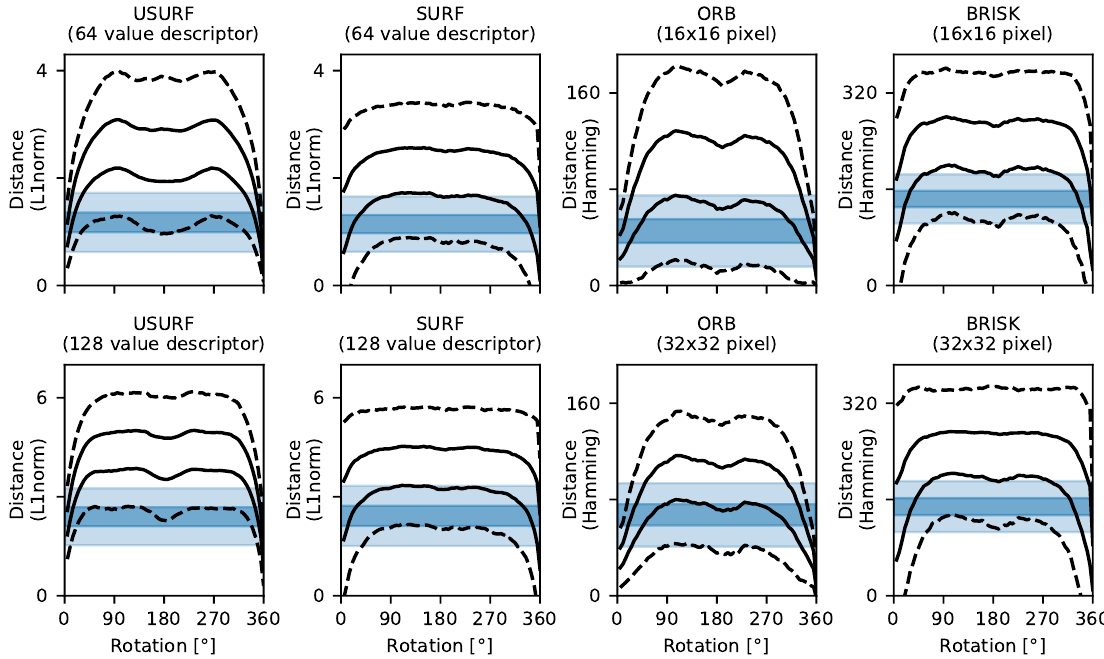
Figure 16. Descriptor discrimination for rotation of the horizontal milling R z = 16 µ m sample. The shaded bands show the 1 and 3 standard deviation spread in the computed descriptor distances for ‘bad’ matches. The lines show the 1 and 3 standard deviation spread in the calculated distances for valid matches after